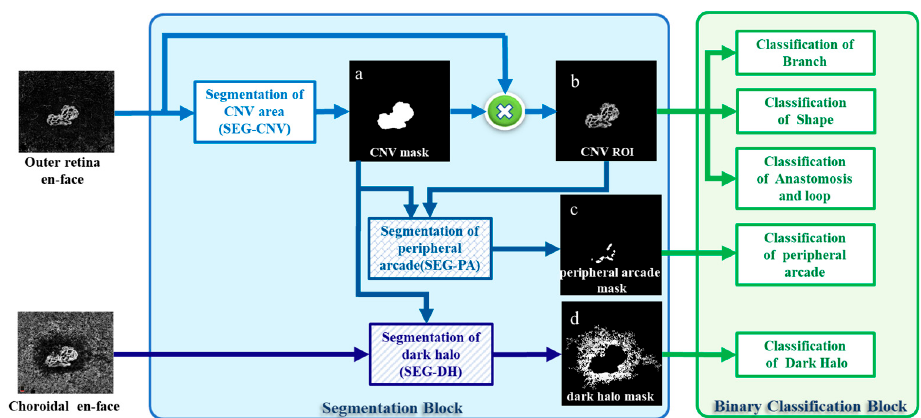
Figure 2. Block diagram of the CNV-Net method including segmentation and classi fi cation blocks. ( a ) Output of SEG-CNV algorithm (CNV Mask), ( b ) Multiplication of CNV mask and the outer retina